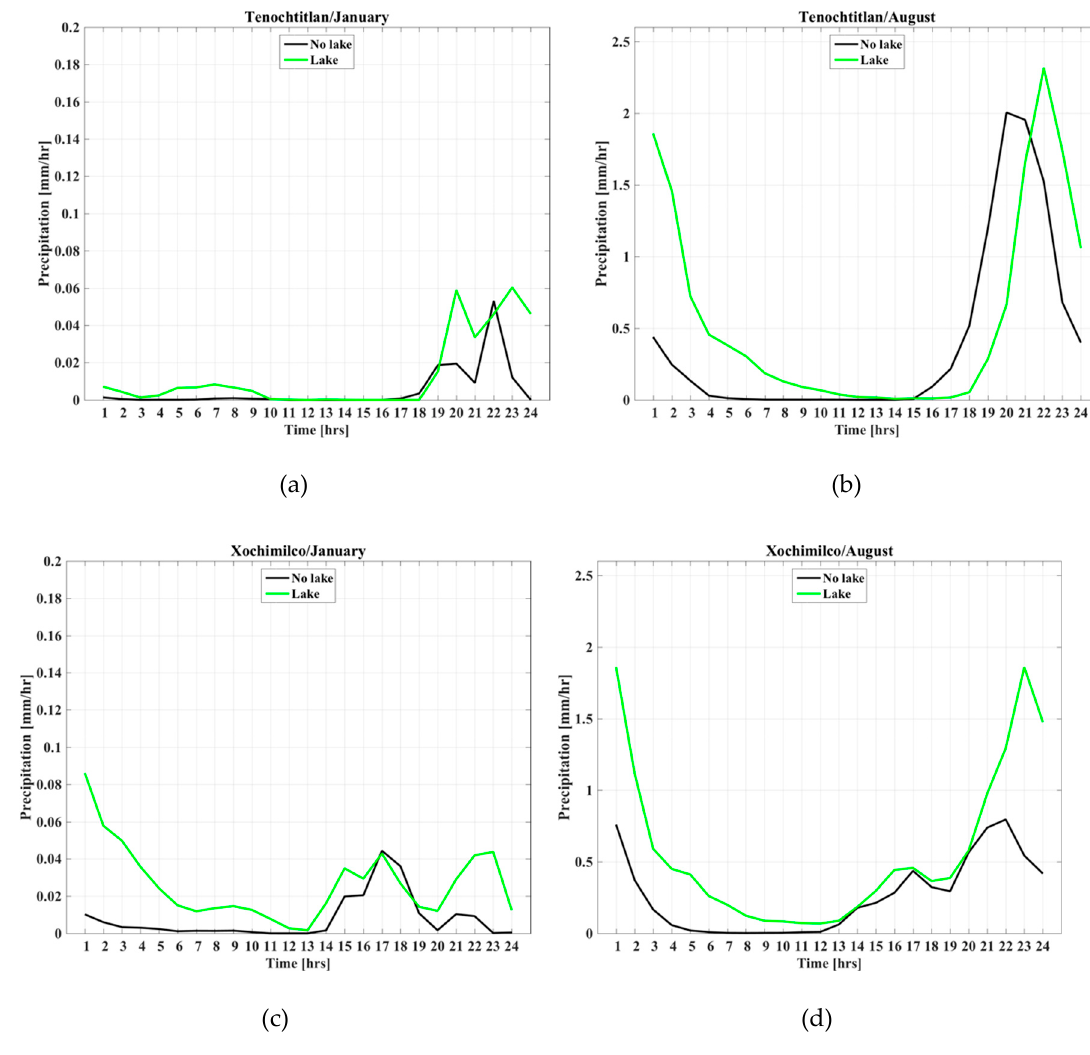
Figure 6. Mean hourly precipitation for: Tenochtitlán in January ( a ) and August ( b ), and Xochimilco in January ( c ) and August ( d ). (No-Lake: NL/WRFc and Lake: L/WRF.)